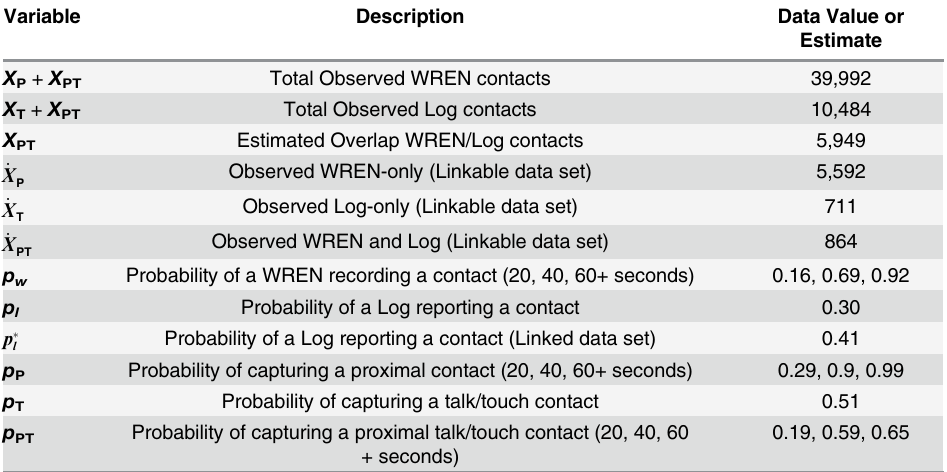
Table 5. Measured contact characteristics between pairs who participated in WREN or Log portions of study, based on class-time and lunch.